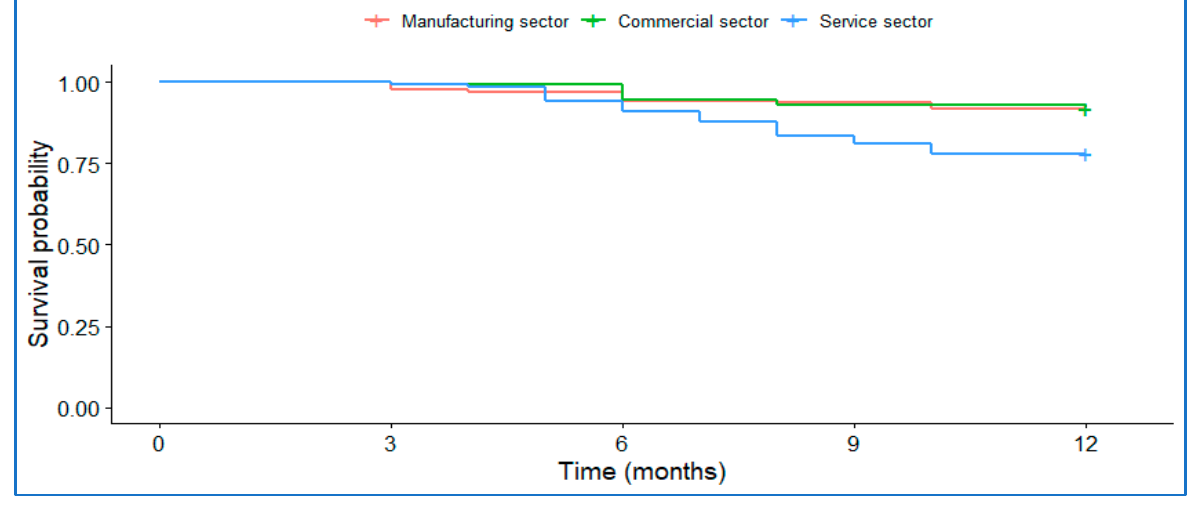
Figure 1. Business sector (S1).